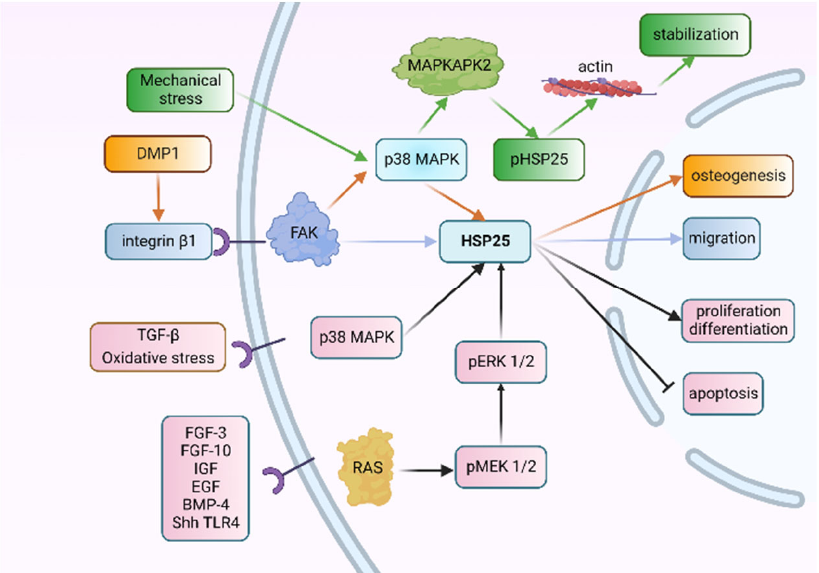
Figure 4. Signal pathways that HSP25 may participate in tooth development and damage repair. HSP25 is mainly involved in ERK/MAPK pathway and p38 MAPK pathway and participates in di ff erent cellular processes according to the received signals. Mechanical stress can phosphorylate HSP25 (pHSP25) through the p38 MAPK pathway, and pHSP25 binds to actin to stabilize cell structure. DMP1 upregulates HSP25 expression and promotes osteogenesis through the p38MAPK pathway. Integrin β 1 can promote cell migration through HSP25. HSP25 receives signals from FGF, IGF, EGF, BMP-4, Shh, TLR4, TGF- β and oxidation stress through ERK/MAPK pathway and p38 MAPK pathway, thus promoting cell proliferation and di ff erentiation and inhibiting apoptosis. Figures created with BioRender.com, accessed on 21 August 2022.